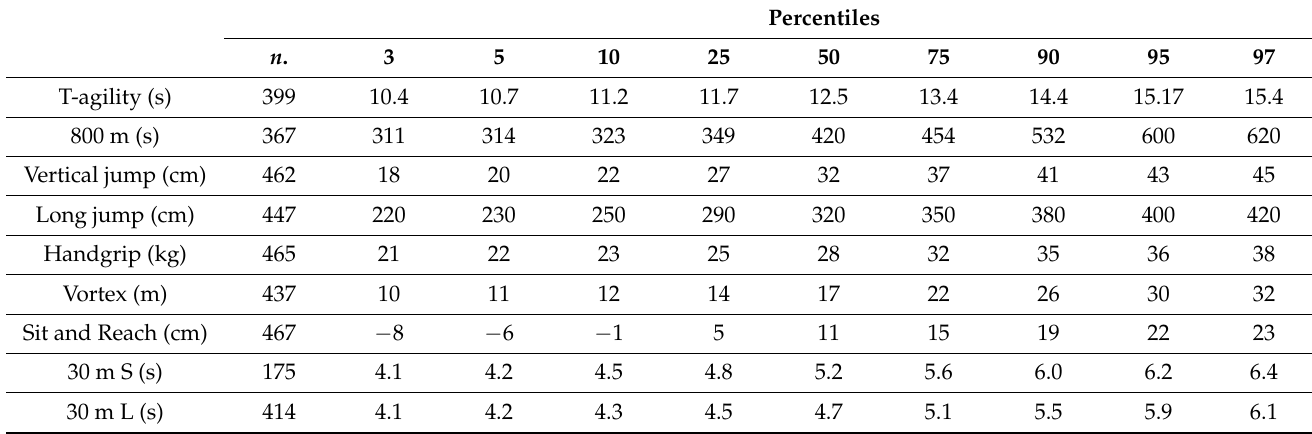
Table 5. Fitness test percentiles for females in the second class of the high